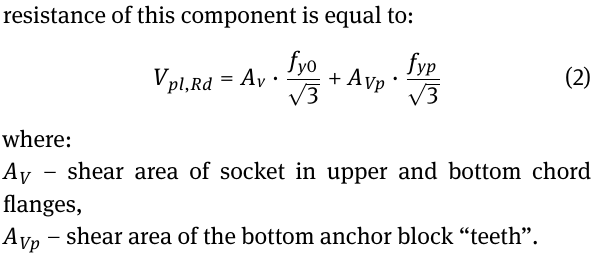
Figure 5: View of the laser made holes in bottom flange of chord